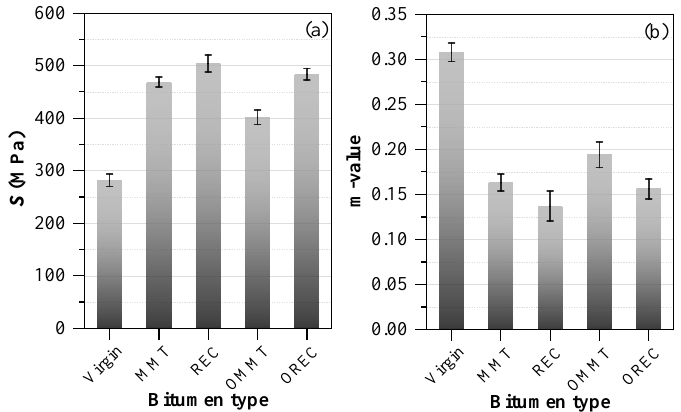
Figure 9. ( a , b ) The S and m-value results at –18 ◦ C for bitumen samples.